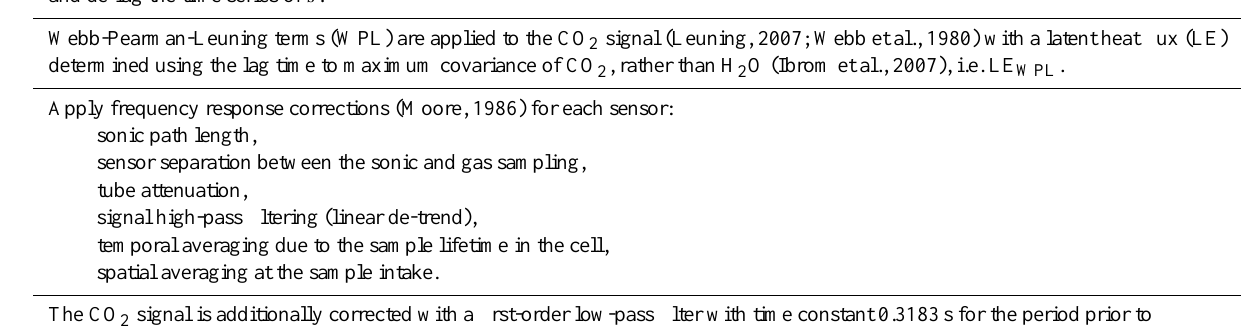
Table 1. Flux data processing routine, implemented in EdiRe (R. Clement, University of Edinburgh, UK). Despike the three wind vector and sonic temperature time series using a detection method based on deviations further than a set number of standard deviations from a moving window mean (Vickers and Mahrt, 1997). The T s - and w-series were despiked using a 4.5 standard deviation threshold, the u-, v-, and CO 2 -series were despiked using a 4.0 standard deviation threshold, and the H 2 O-series was despiked using a 3.5 standard deviation threshold, reflecting their different probability distributions. Angle of attack correction for the response of the sonic anemometer (Nakai et al., 2006). Double coordinate rotation in order to: (i) rotate u into the mean horizontal wind and (ii) reduce mean w to zero. Linearly de-trend the scalar time series and calculation of flux estimate. Determine cross-correlation sequence of 30-min interval to find the lag time which maximizes the covariance of scalar